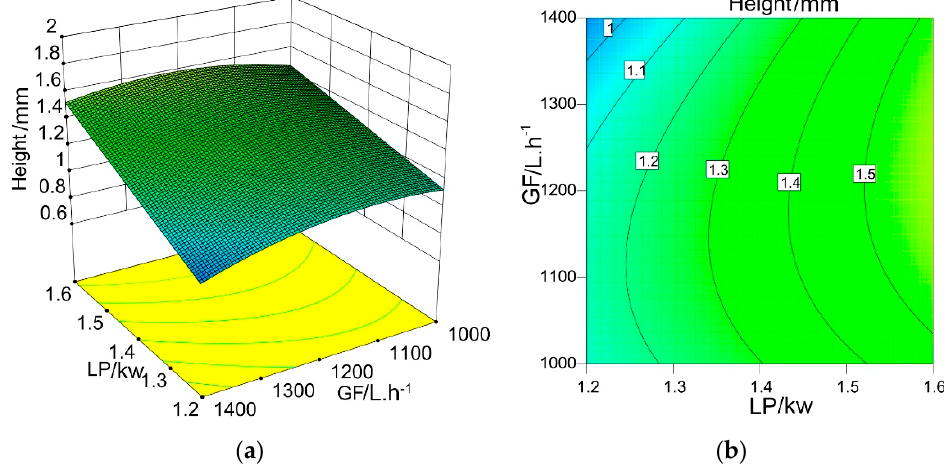
Figure 10. ( a ) 3D response surface showing the influence of laser power and gas flow on clad height. ( b ) Contour line of the response surface.